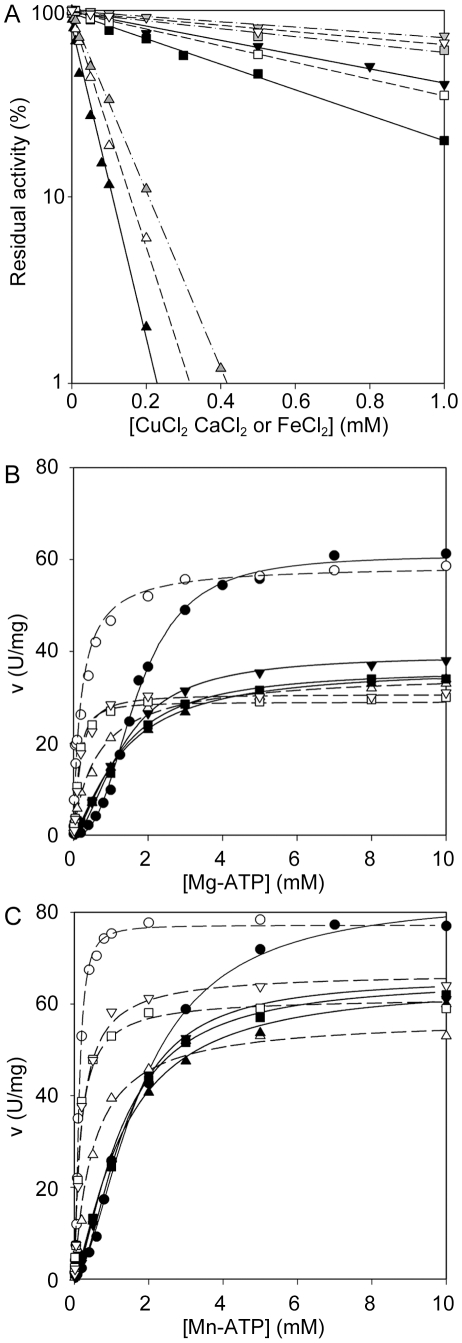
Inhibition of MtbPRPPase by divalent cations.(A) Response of PRPPase activity to CuCl2 (▴), CaCl2 (▾) and FeCl2 (▪) different concentrations. All measurements were performed at 2 mM R5P and 5 mM Mg-ATP, in the absence (black symbols), and in the presence of 5 mM MgCl2 (white symbols) or 5 mM MnCl2 (gray symbols). (B) Steady state kinetics vs Mg-ATP, at 2 mM R5P in the absence (•) and in the presence of 0.02 mM CuCl2 (▴), 0.8 mM CaCl2 (▾) and 0.4 mM FeCl2 (▪), concentrations. Measurements were performed either in the absence (filled symbols) or in the presence (open symbols) of 5 mM MgCl2 (C) Steady state kinetics vs Mn-ATP, at 2 mM R5P in the absence (•) and in the presence of 0.02 mM CuCl2 (▴), 0.8 mM CaCl2 (▾) and 0.4 mM FeCl2 (▪), concentrations. Measurements were performed either in the absence (filled symbols) or in the presence (open symbols) of 5 mM MnCl2.